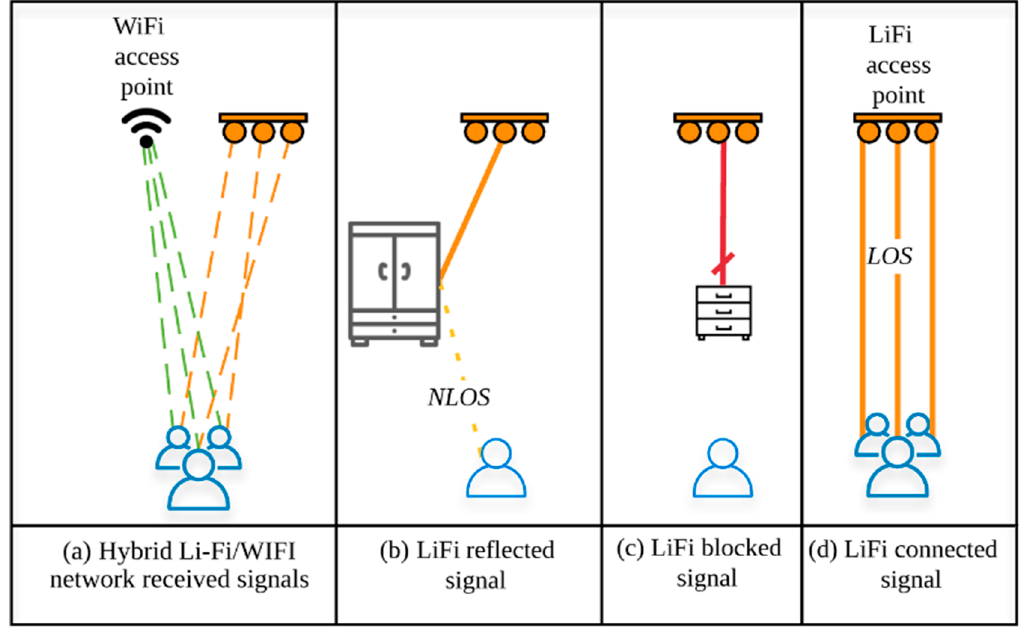
Figure 9. (a) Hybrid LiFi/Wi-Fi network, (b) reflected signal NLOS, (c) blocked signals by objects, and (d) connected LiFi Figure 9. ( a ) Hybrid LiFi/Wi-Fi network, ( b ) reflected signal NLOS, ( c ) blocked signals by objects, and ( d ) connected LiFi LOS signals. LOS